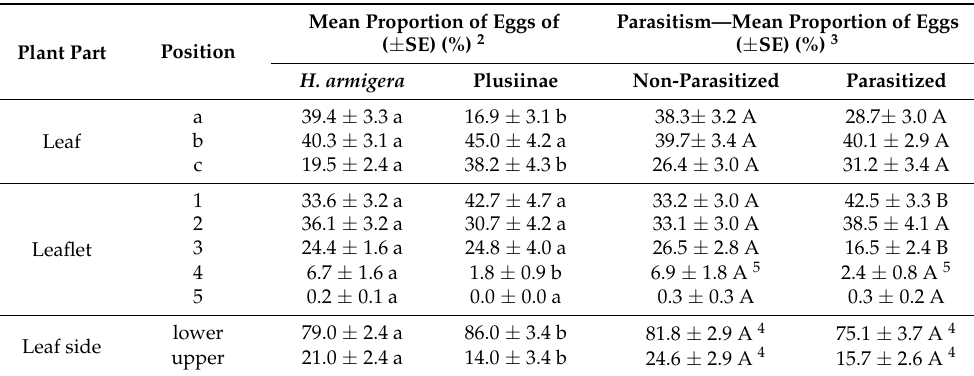
Table 1. Location of Helicoverpa armigera and Plusiinae eggs in processing tomato crops in Ribatejo— proportion (in %) of tomato fruitworm eggs and of Plusiinae eggs on each leaf, leaflet, and leaf side 1 , and mean proportion of parasitized and non-parasitized eggs of tomato fruitworm and Plusiinae (SE-Standard error of the mean).